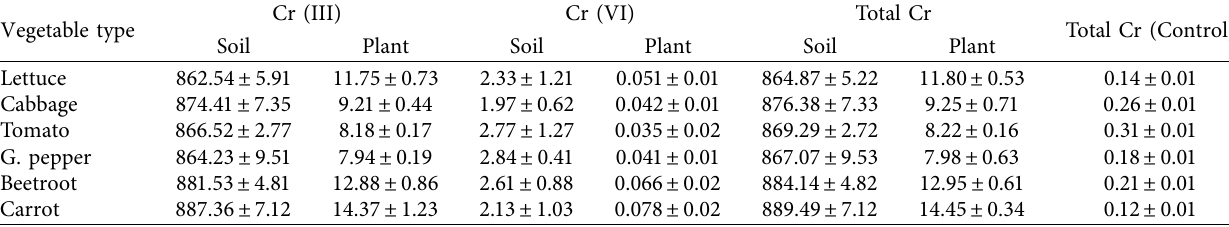
Table 3: Chromium concentration in edible plants grown in the tannery surroundings [mg kg − 1 mean ± SD, n � 3]. Vegetable type